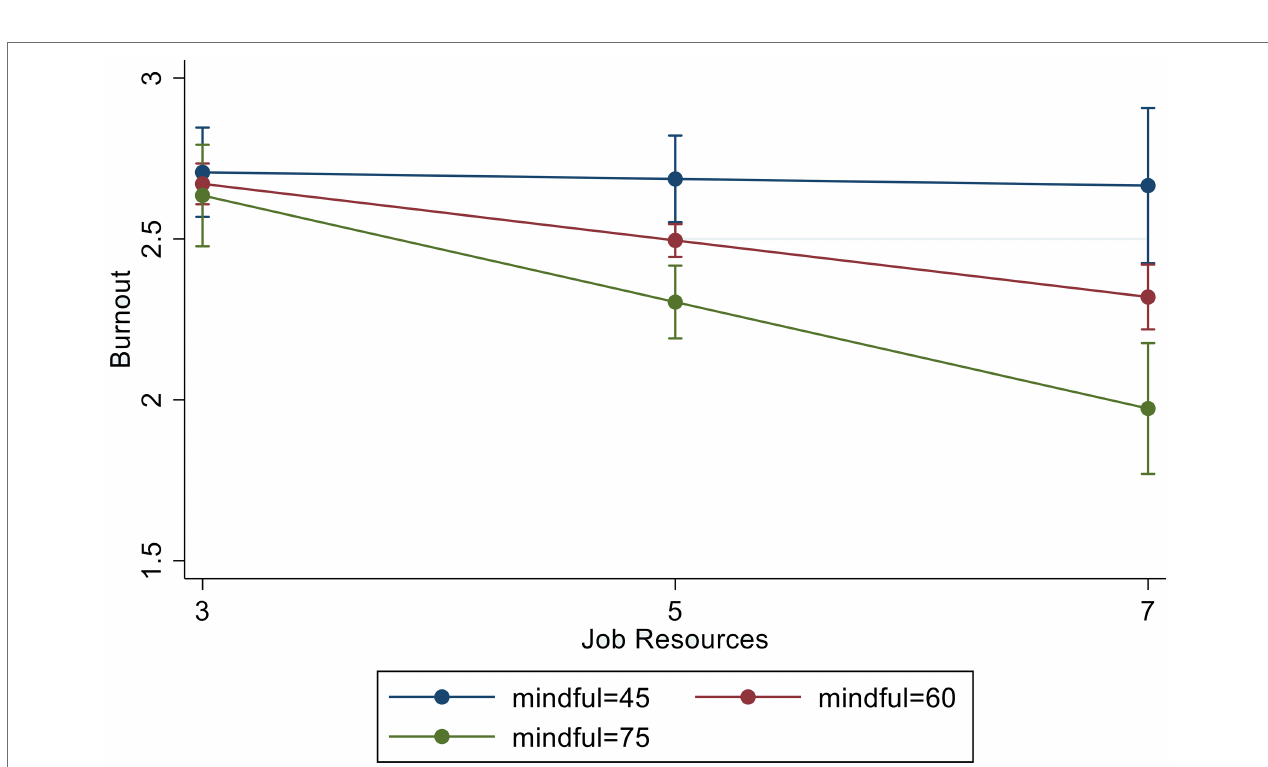
FIGURE 2 | Burnout by job resources and mindfulness.